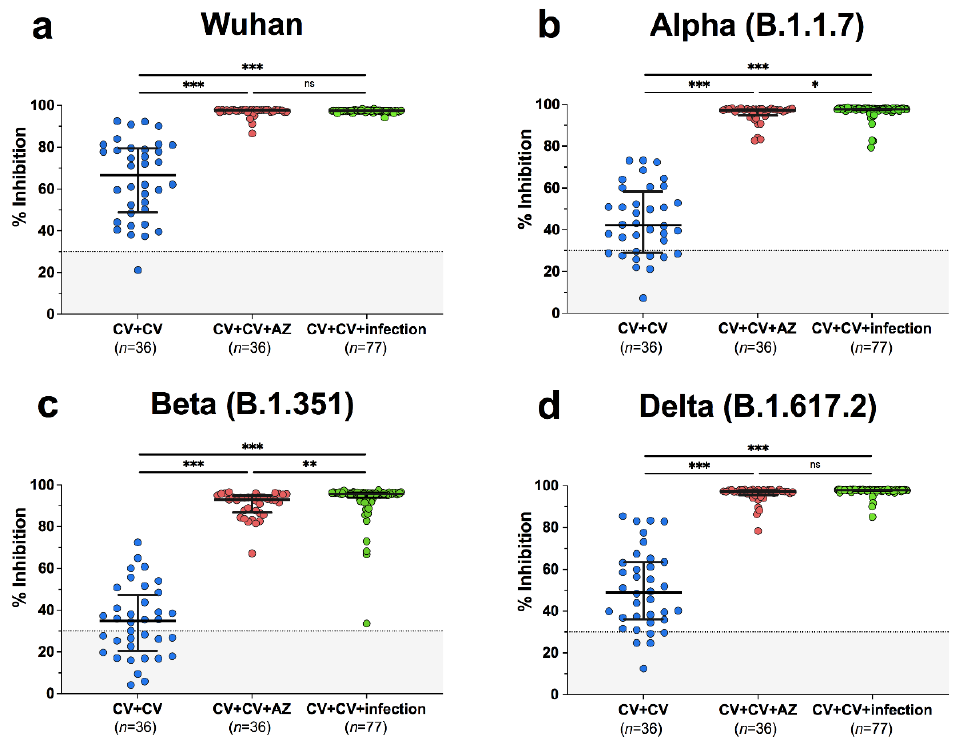
Figure 2. Neutralizing activities against ( a ) wild-type, ( b ) B.1.1.7-alpha, ( c ) B.1.351-beta, and ( d ) B.1.617.2-delta using surrogate virus neutralization test (sVNT). The fully vaccinated individuals with two doses of CoronaVac (CV+CV), the fully vaccinated individuals with two doses of CoronaVac then administered a third vaccination with AZD1222 (CV+CV+AZ), and the fully vaccinated individuals with two doses of CoronaVac followed by SARS-CoV-2 breakthrough infection (CV+CV+infection) were compared. Median values with IQRs are shown as horizontal bars. Dotted lines indicate cut-off values, and grey shaded areas depict values under the cut-off. Statistics were calculated using Kruskal–Wallis tests with Dunn’s post hoc correction. * p < 0.05, ** p < 0.01, *** p < 0.001. ns indicates no statistical significance.